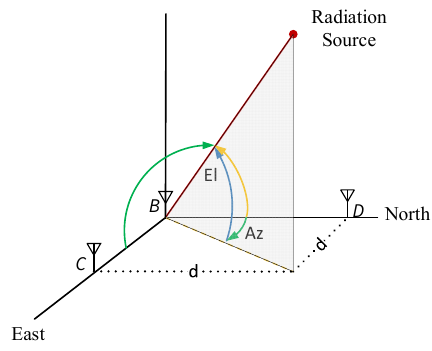
Figure 2. Basic interferometer geometry [9,19].